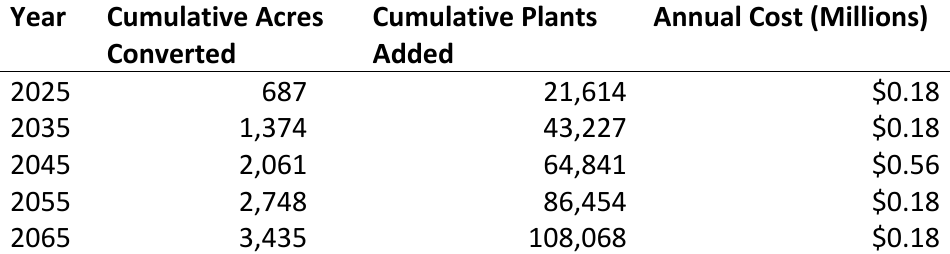
Table A1.6. Annual revenue and costs for native forest restoration scenario